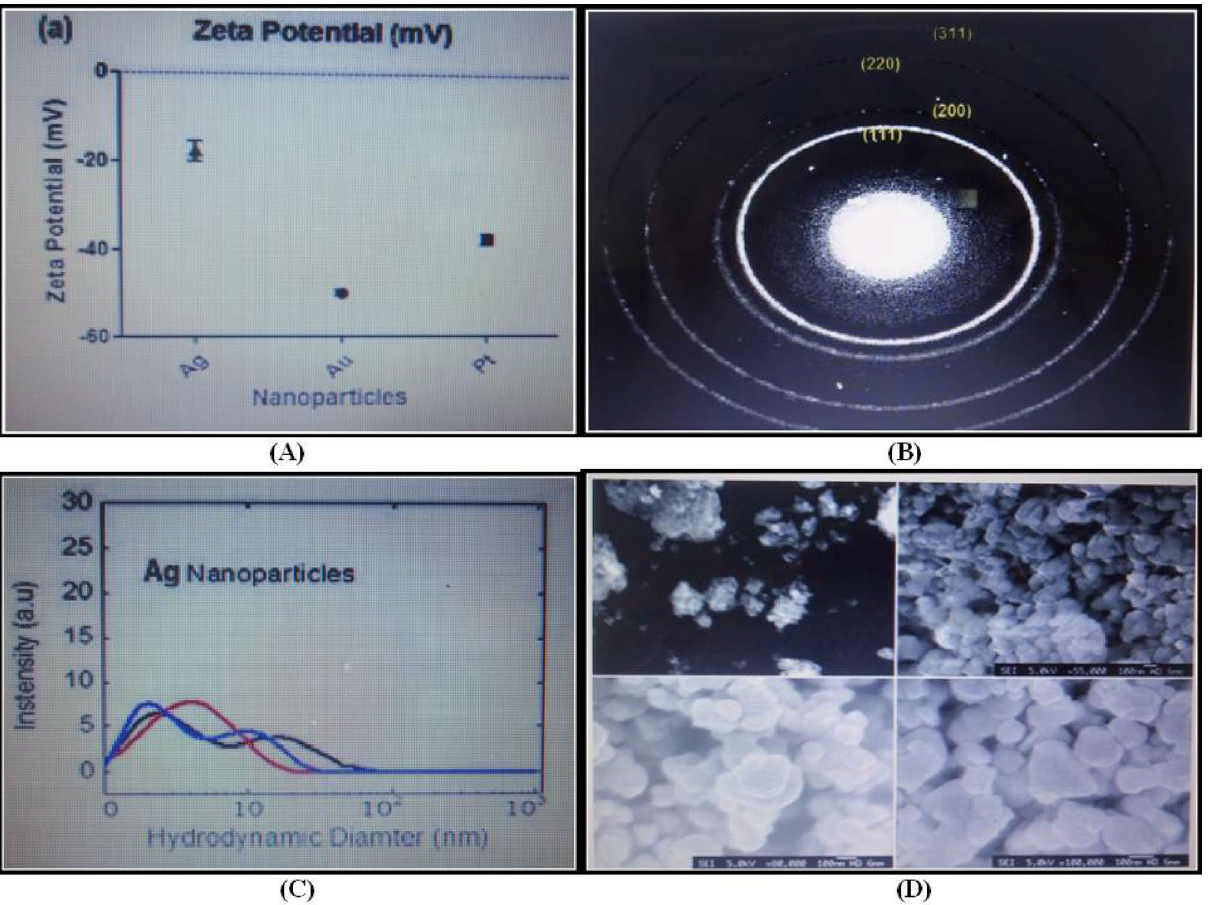
Figure 7. Myco-genized AgNPs ( A ) Zeta potential measurements for mycogenized AgNPs. ( B ) SAED analysis ( C ) Dynamic Light Scattering (DLS) measurements ( D ) SEM micrographs of